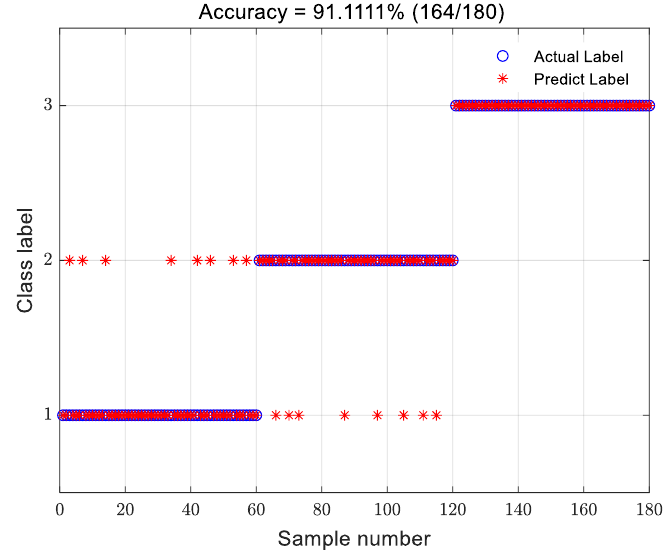
Figure 14. Identification results of the testing set.